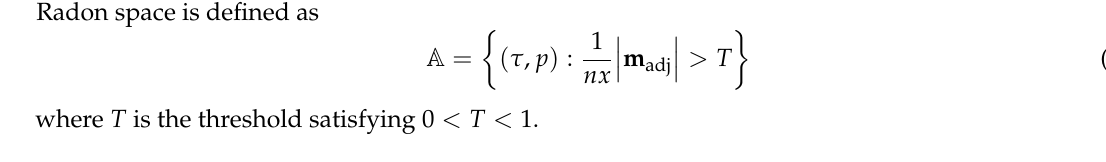
Table 1. The parameters of Model 1.